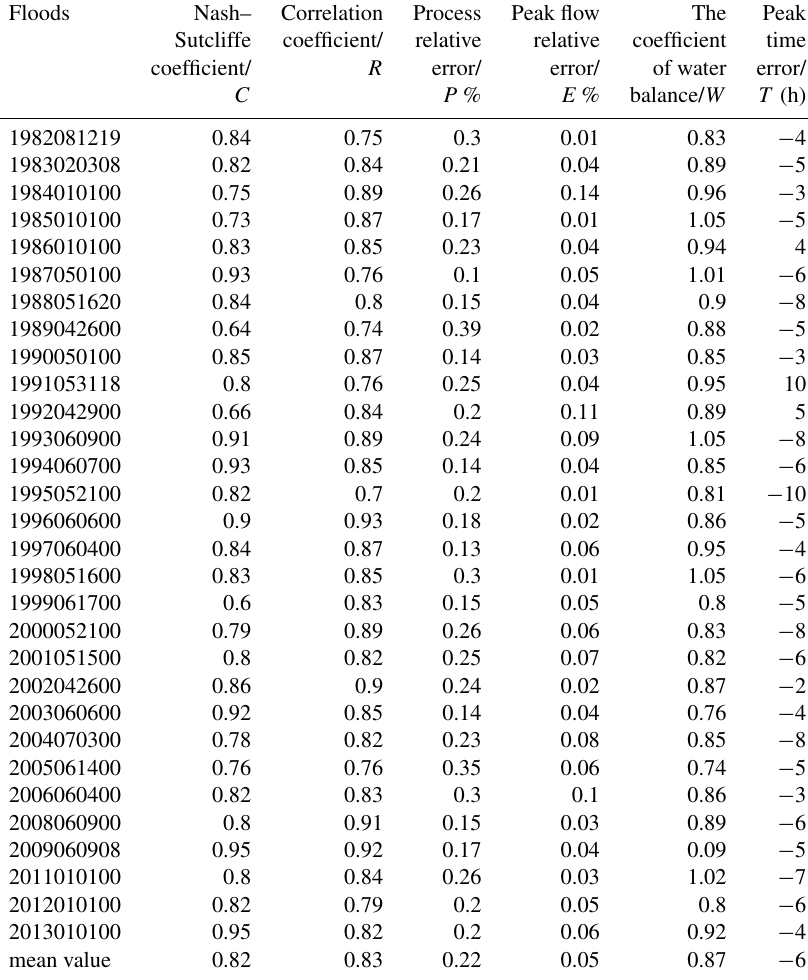
Table 5. The evaluation indices of the simulated flood results based on the Liuxihe model in the LKRB. Floods Nash– Correlation Process Peak flow The Peak Sutcliffe coefficient/ relative relative coefficient time